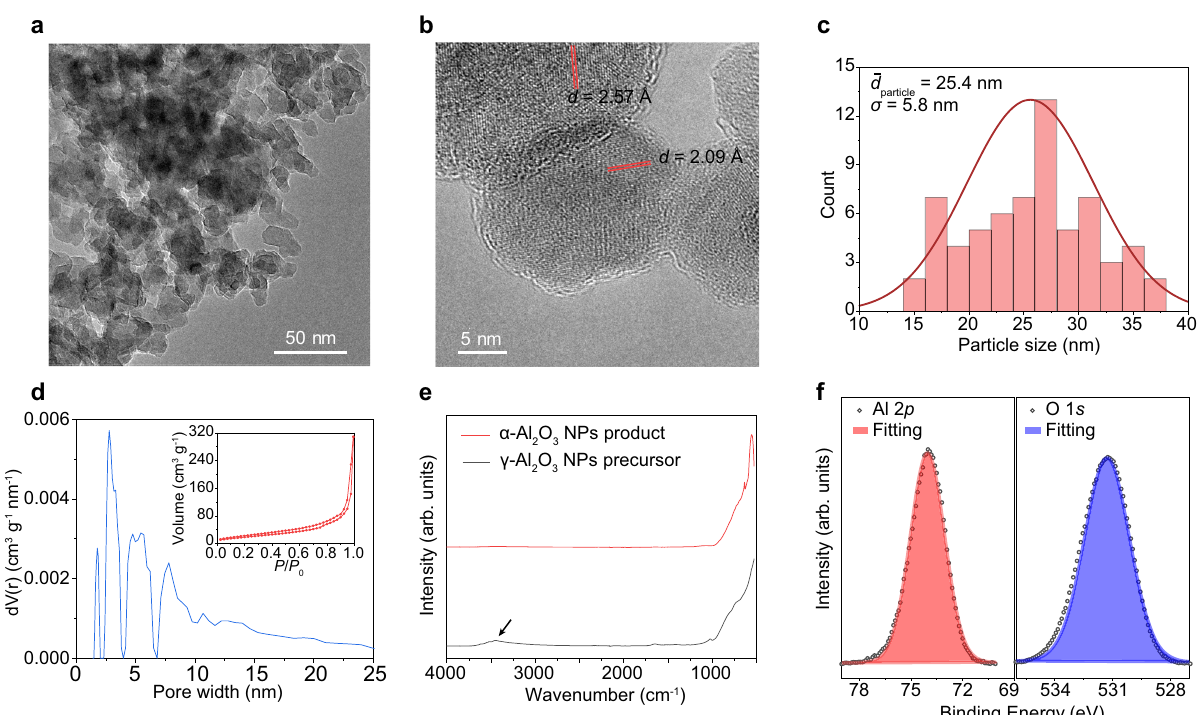
Fig. 2 | Characterization of the α -Al 2 O 3 NPs. a Bright- fi eld transmission electron application of density functional theory (DFT) model to the N 2 isotherm. Inset, N 2 adsorption – desorption isotherm of as-synthesized α -Al 2 O 3 NPs at 77K. e Fourier- microscopy (BF-TEM) image of the α -Al 2 O 3 NPs. b High-resolution TEM (HRTEM) image of the α -Al 2 O 3 NPs. The d spacing of 2.57Å and 2.09Å correspond to the transforminfrared(FT-IR)spectraofthe γ -Al 2 O 3 NPsprecursorandthe α -Al 2 O 3 NPs d (10 (cid:1) 14) and d (11 (cid:1) 23) of α -Al α -Al product. The black arrow points to the hydroxyl group absorbance. f X-ray pho- 2 O 3 . c Histogram and distribution of the 2 O 3 NPs toelectron spectroscopy (XPS) fi ne spectra of Al and O of the α -Al 2 O 3 particle size determined by TEM. d Pore width distribution determined by the